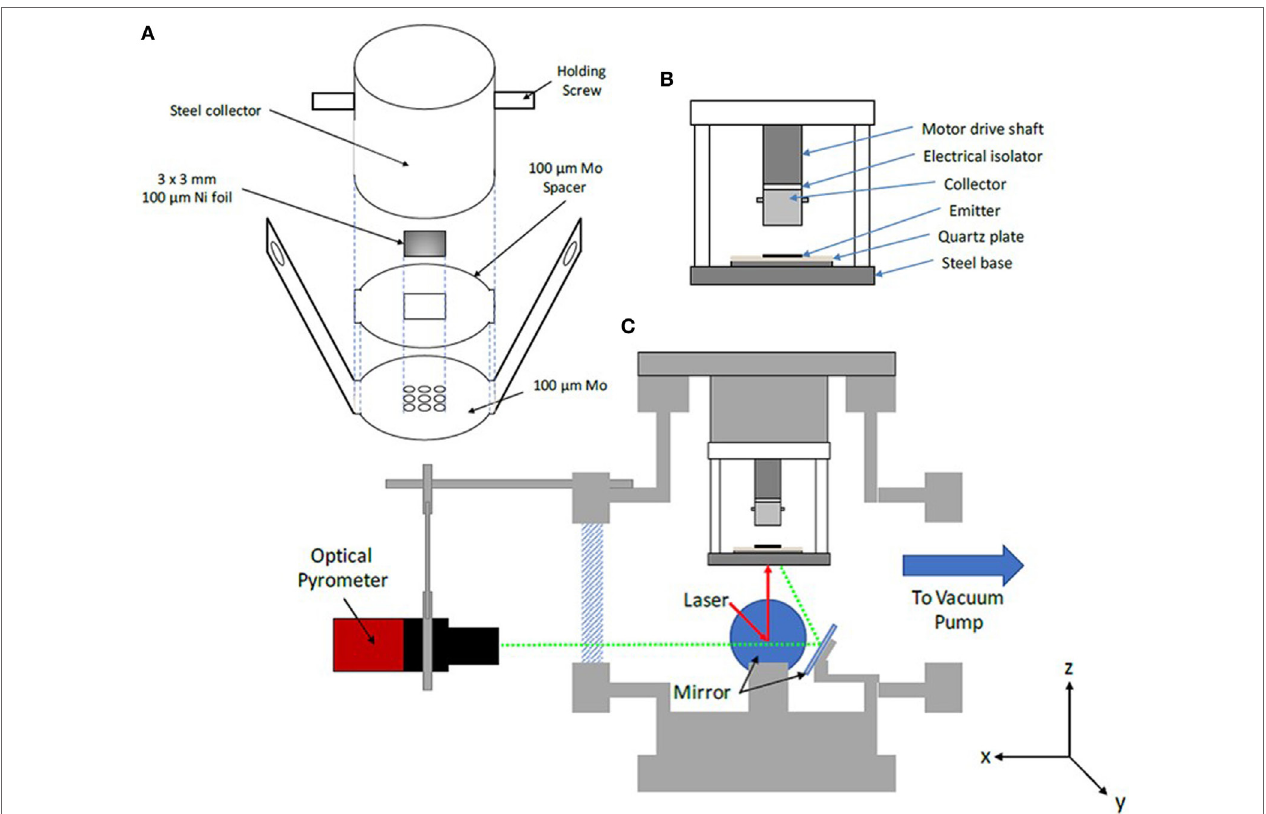
FigUre 1 | Schematic representations of the experimental equipment. (a) show the molybdenum housing for the Ni foil within the collector, (B) shows each of the parts of the thermionic diode structure with electrical connections omitted for clarity, and (c) shows the entire test set-up, showing how both the laser ( y -axis) and pyrometer ( x -axis) are directed at the sample via